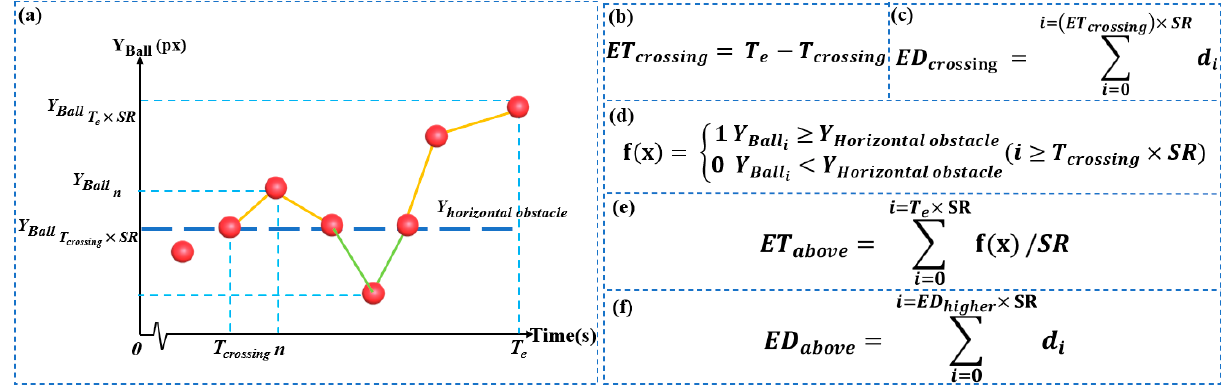
Figure 3. Sequence diagram of the change of the sphere’s Y coordinates and related formulas. ( a ) Sequence diagram of the change of the Y coordinate after the sphere crosses the horizontal obstacle, ( b ) calculation formula for ET crossing , ( c ) calculation formula for ED crossing , ( d ) discriminant of whether to cross a horizontal obstacle or not, ( e ) calculation formula for ET above , ( f ) calculation formula for ED above .